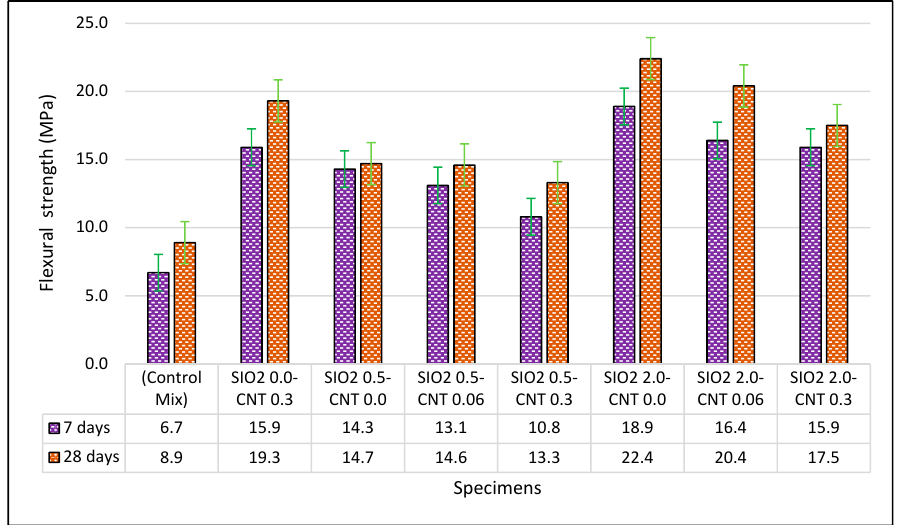
Figure 4. Flexural strength of cement paste specimens at the ages of 7 and 28 days.